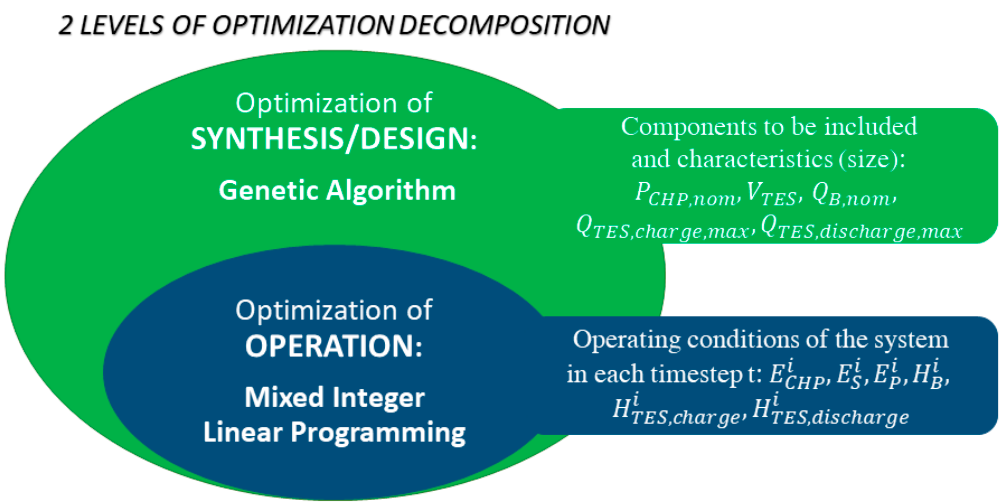
Figure 2. Outline of the bi-level optimization algorithm. Table 1. Settings and parameters for the optimization